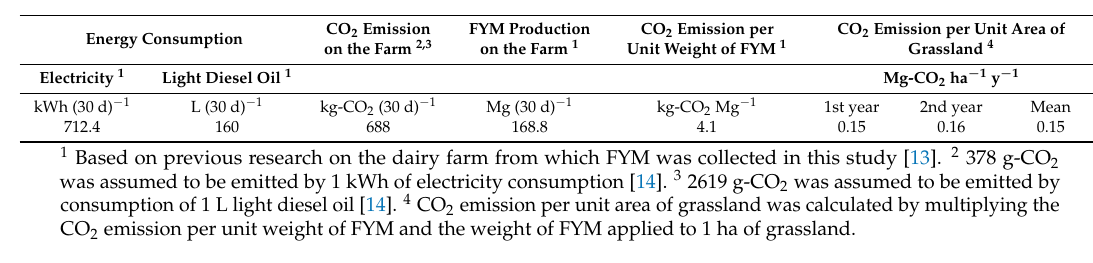
Table 4. Emission of CO 2 related to energy consumption for composting dairy FYM.